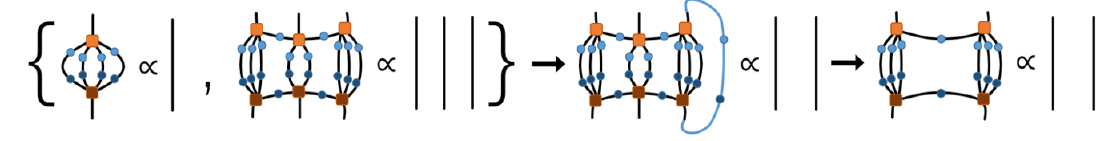
Figure 5 . Logical derivation of tensor constraint At the (cid:12)rst step, we contract the right-most index of constraint constraint derive constraint